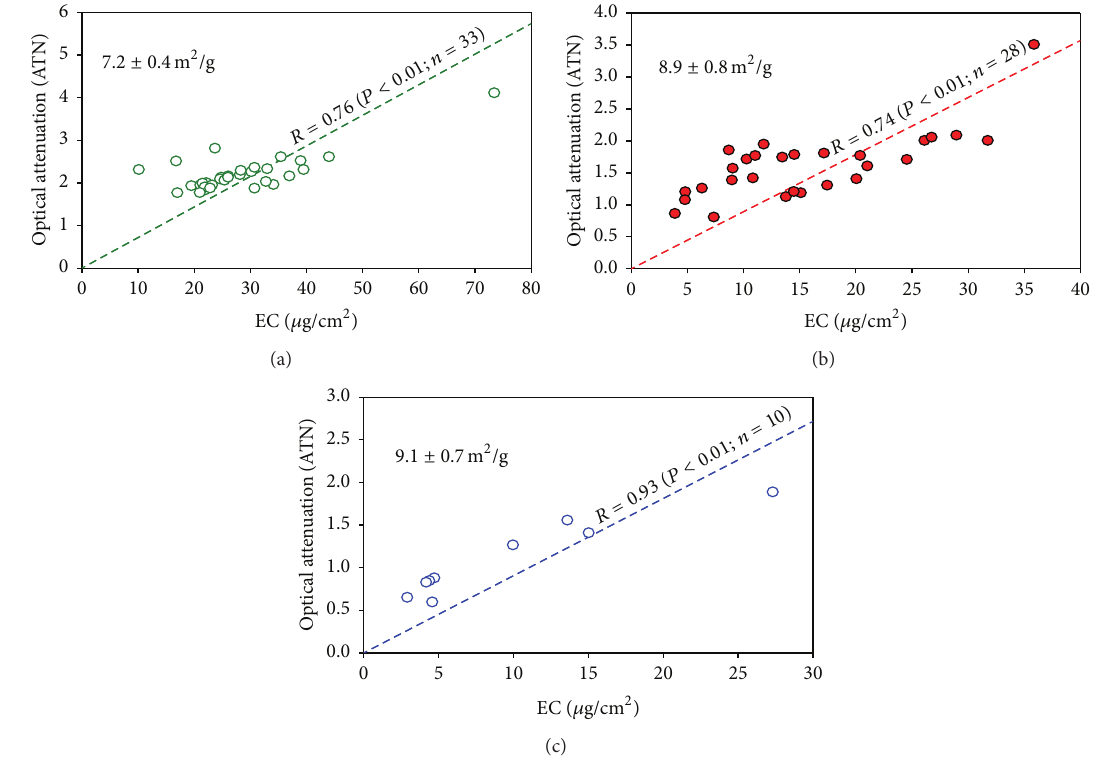
Figure 5: Attenuation cross section of EC at 678 nm ( 𝜎 in m 2 g −1 ) during: (a) paddy-residue burning emission (October-November); ATN-ECOC (b) emissions from biofuel burning and fossil-fuel combustion (December–March); and (c) wheat-residue burning emission